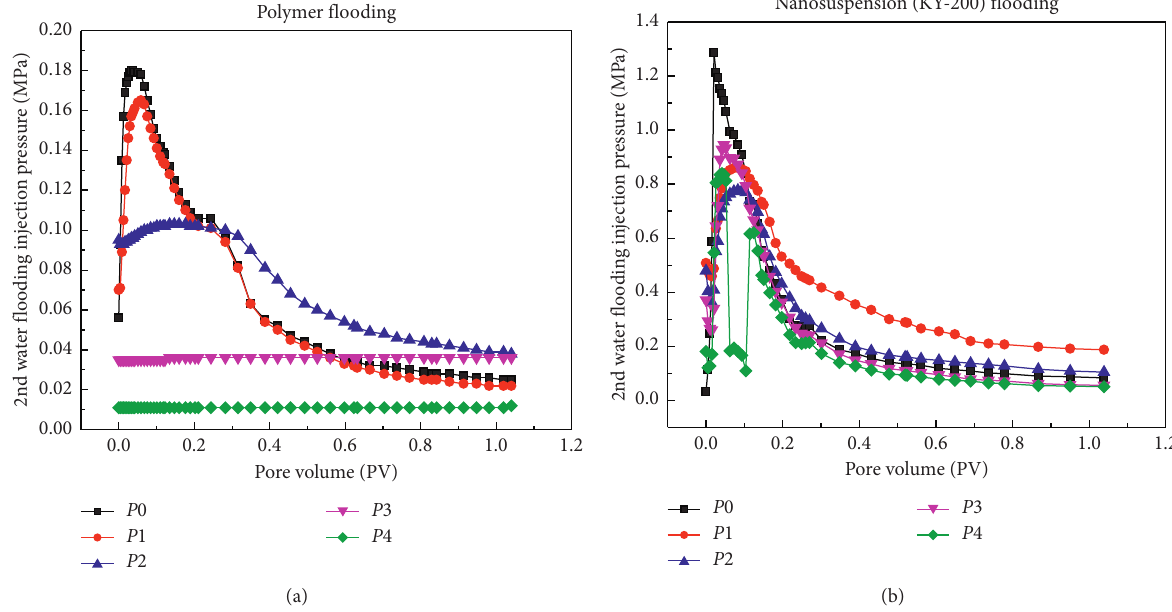
Figure 5: Second water flooding pressure curves of polymer gel and nanosuspensions.